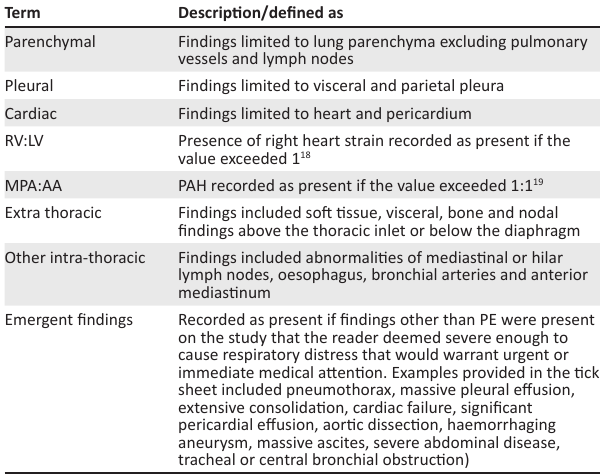
FIGURE 1: Axial CT of two different patients with pulmonary embolism. (a) Demonstrating a large saddle embolus; (b) demonstrating a filling defect in the right descending pulmonary artery complicated by bilateral pleural effusions, peripheral consolidations and a wedge-shaped pulmonary infarct on the left. TABLE 1: Description of